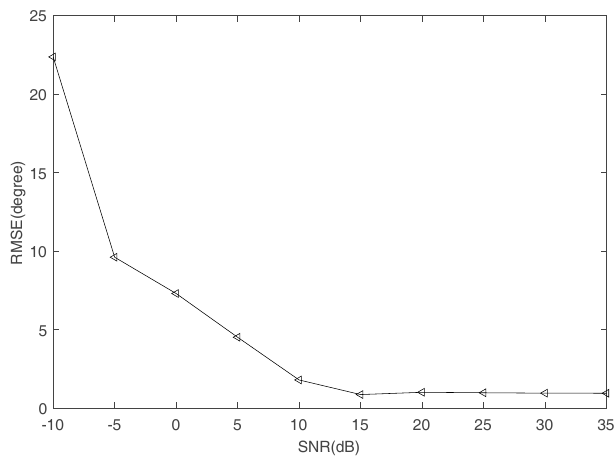
Figure 16. The comparison between the true and estimated DOA.